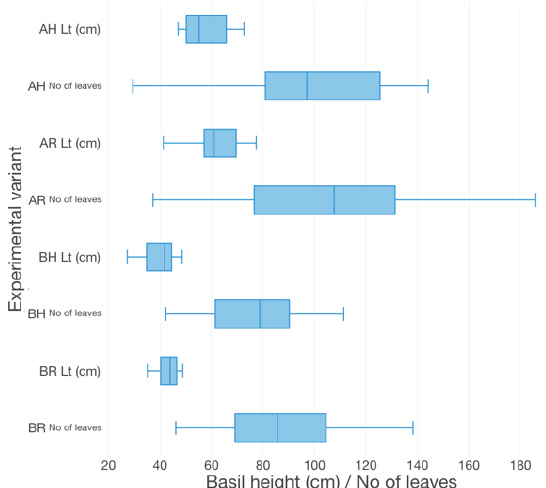
Plants 2023 , 12 , 540